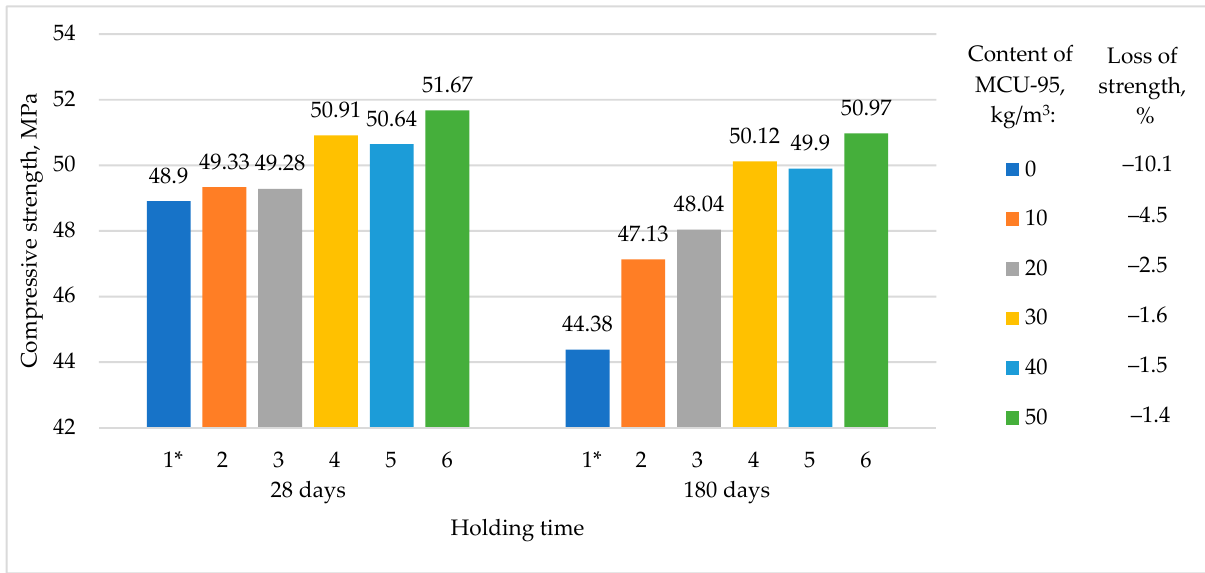
Figure 10. Weight reduction of RHC samples after frost resistance tests. * Reference composition.